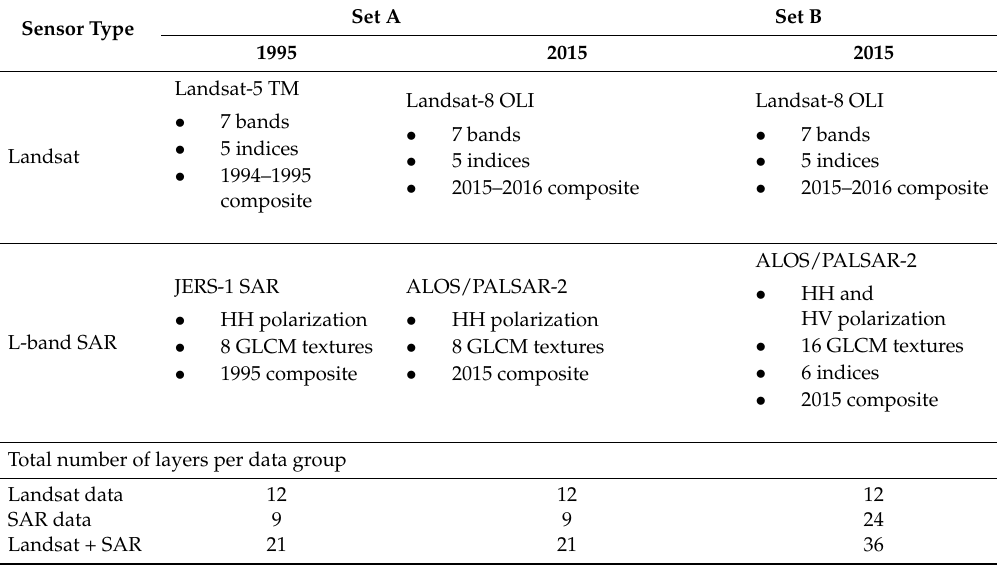
Table 2. Organization of datasets, layer composition for each sensor type in each dataset, and total number of layers per data